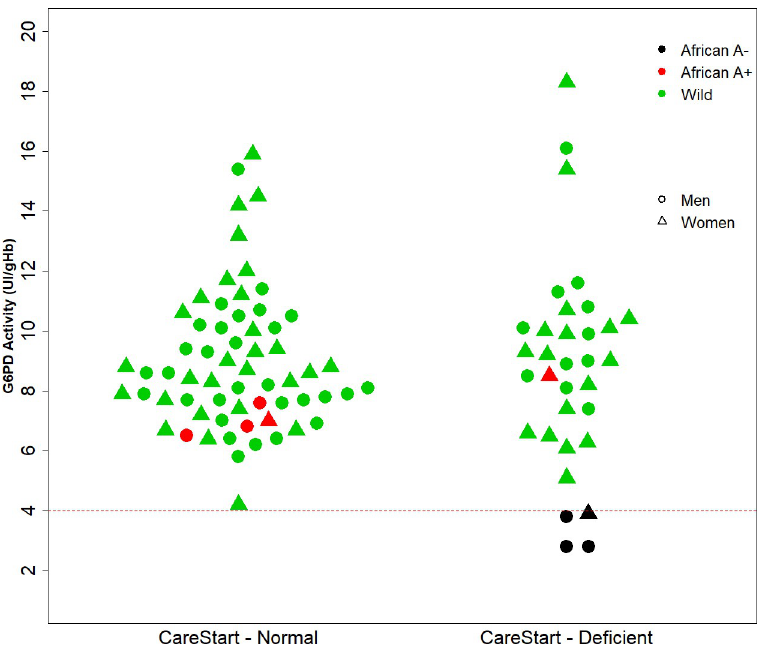
Fig 3. G6PD activity quantitation and genotyping of G6PD RDT normal and deficient samples. G6PD activity measured by point-of-care quantification (Y axis) is shown for CareStart RDT normal and deficient samples (X axis left and right, respectively) in Rio Preto da Eva, Brazil. G6PD African A-, African A+ and wild type variants are indicated by black, red and green colors, respectively. Circles below the red-dashed line (cut-off point 4.0 UI/g Hb) are considered G6PD deficient ( < 30%) as per quantitative test